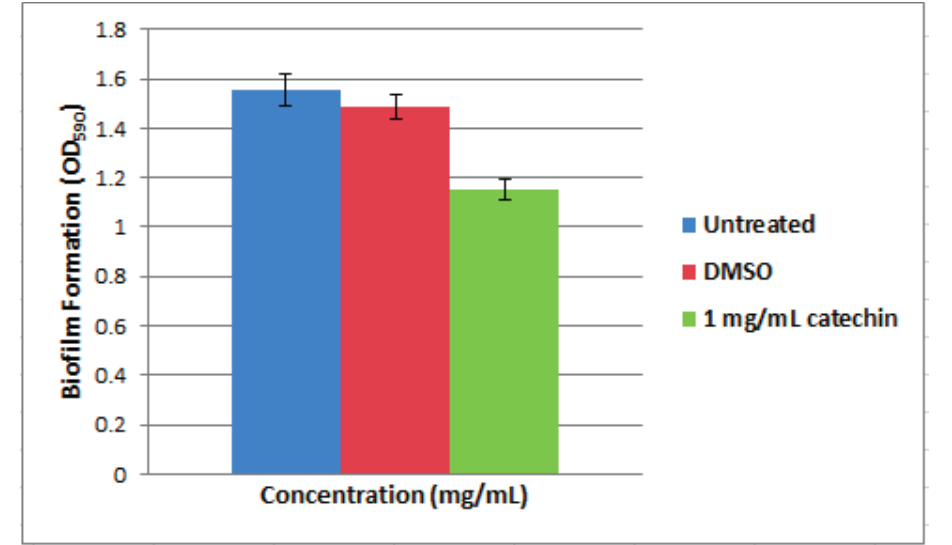
Figure 4. Qualitative analyses of biofilm formation and inhibition by anti-QS compound, catechin. Bars: Standard errors of the